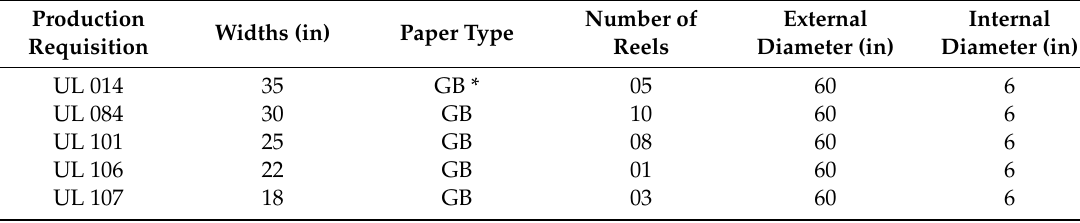
Table 3. Stocked over-produced and leftover